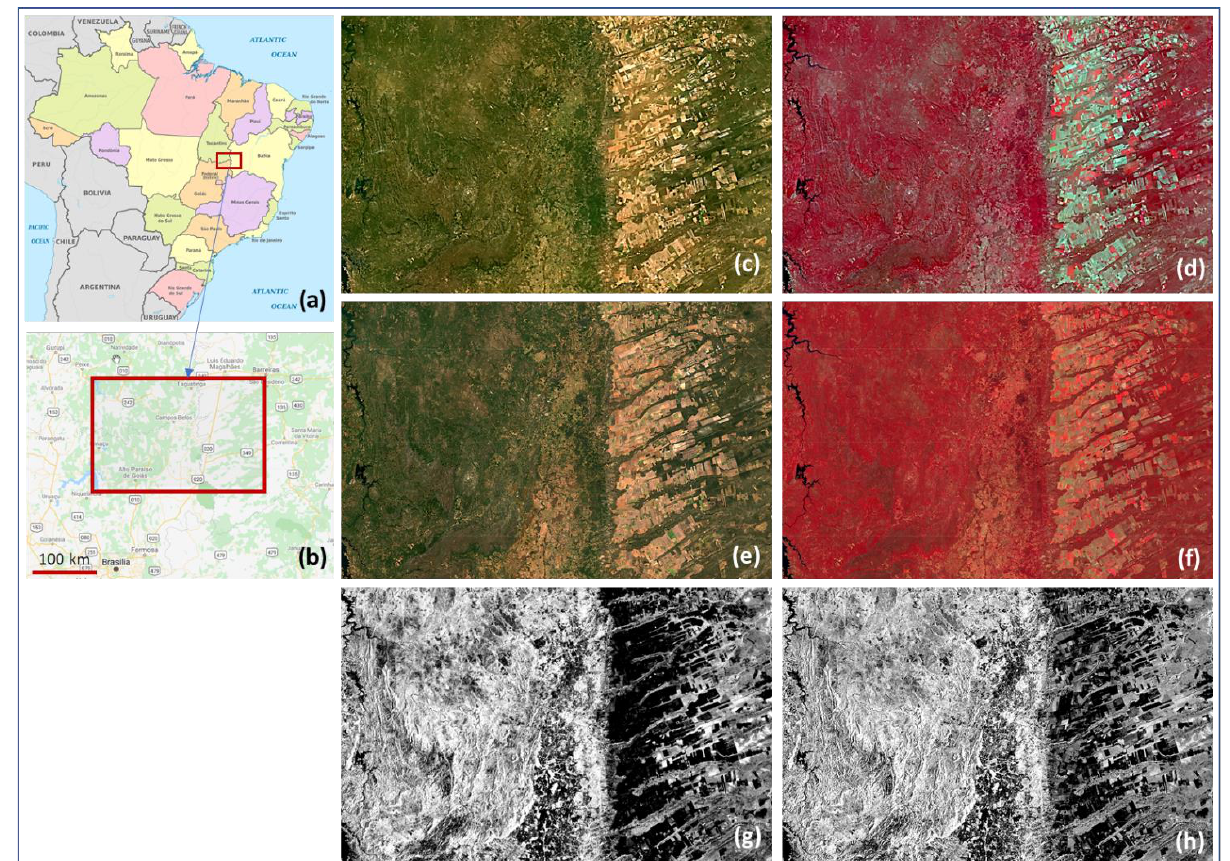
Figure 1. Study area location in Brazil ( a , b ). Visible and infra-red composite images of PlanetScope ( c , d ) and Sentinel 2 ( e , f ). VV ( g ) and VH ( h ) composite images of Sentinel 1. Table 1. Land cover classes and number of sample points used in the